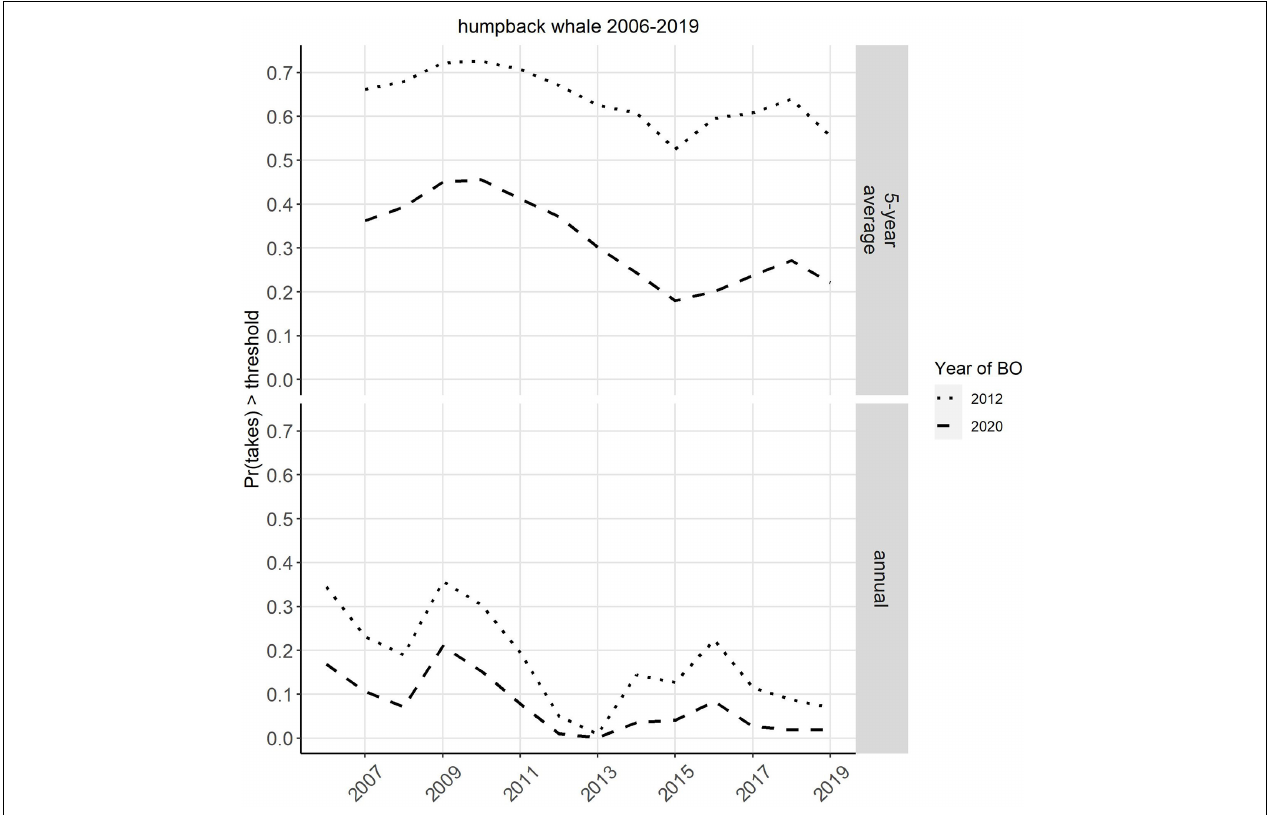
FIGURE 2 | Probability of the 5-year average take estimate (top) or annual take estimate (bottom) exceeding the take threshold specified in the 2012 (dotted line) or 2020 (dashed line) Biological Opinion (BO) Incidental Take Statement. Currently these fisheries operate under the 2020 BO, which superseded the 2012